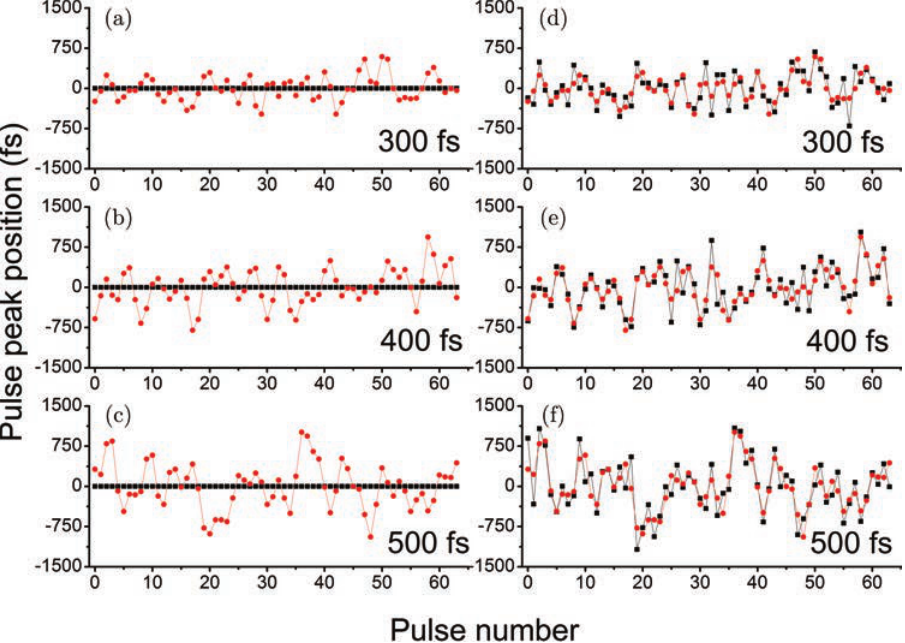
Fig. 2. Pulse peak positions (deviation from their nominal positions without timing jitter) of the mode-locked laser (black squares) and the synchronized time-lens source (red circles) of three typical simulation runs for (a) 300-fs, (b) 400-fs and (c) 500-fs photodetection introduced electrical timing jitter. For comparison, pulse peak positions are also shown for (d) 300-fs, (e) 400-fs and (f) 500-fs intrinsic optical timing jitter in the mode-locked laser.